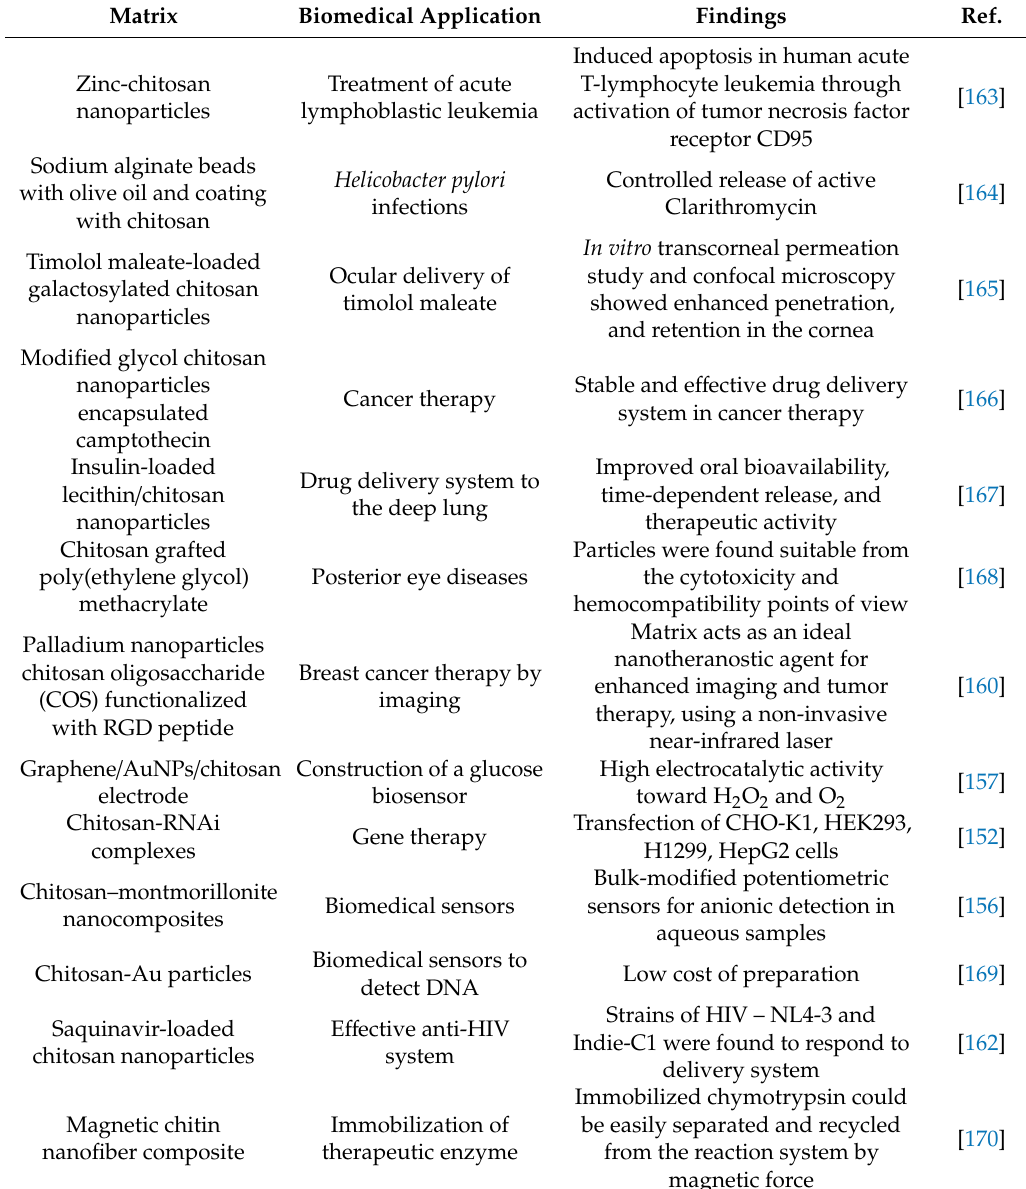
Table 6. Selected emerging chitosan-based biomedical